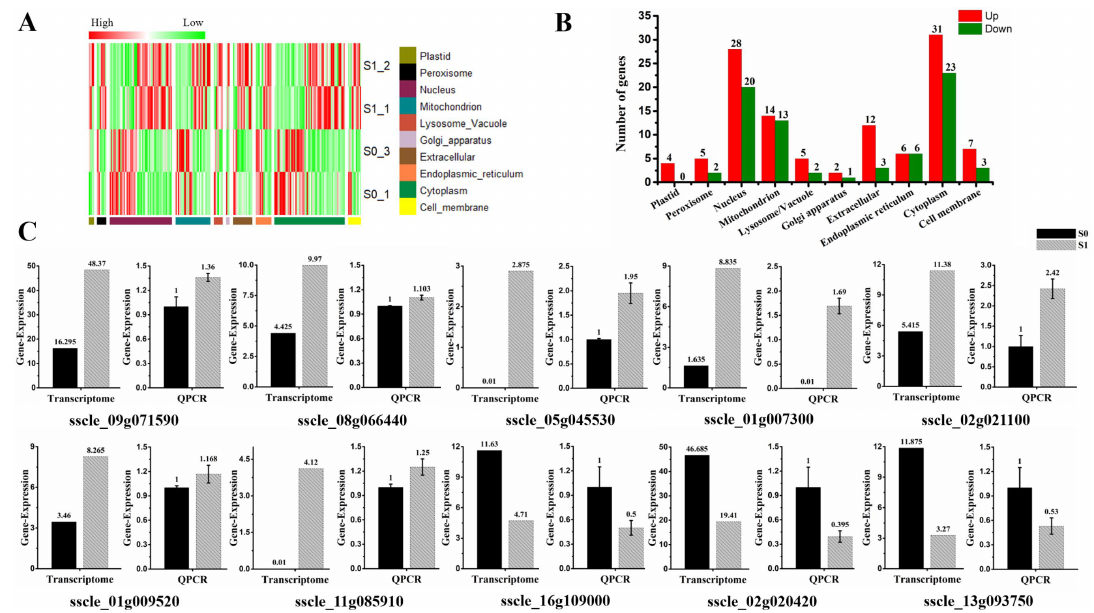
Figure 3. Subcellular localization of differential expression gene involved in SsHADV-1 virions infection. ( A ) Heat map enrichment analysis of all differentially expressed genes. Row clustering was carried out based on subcellular localization. The column represents the individual treatment sample. Down-regulated DEGs are displayed in green color, and up-regulated DEGs in red. The brightness of each color corresponds to the magnitude of the difference when compared against the average value. ( B ) Histogram of differentially expressed genes in various organelles, which respectively shows the number of up-regulated (red) and down-regulated (green) genes in each cell structure. ( C ) RT-qPCR validated the expression of cell membrane-related DEGs (seven up-regulated and three down-regulated DEGs). Three technical replicates were performed for each RT-qPCR. The ubiquitin gene was used as a reference